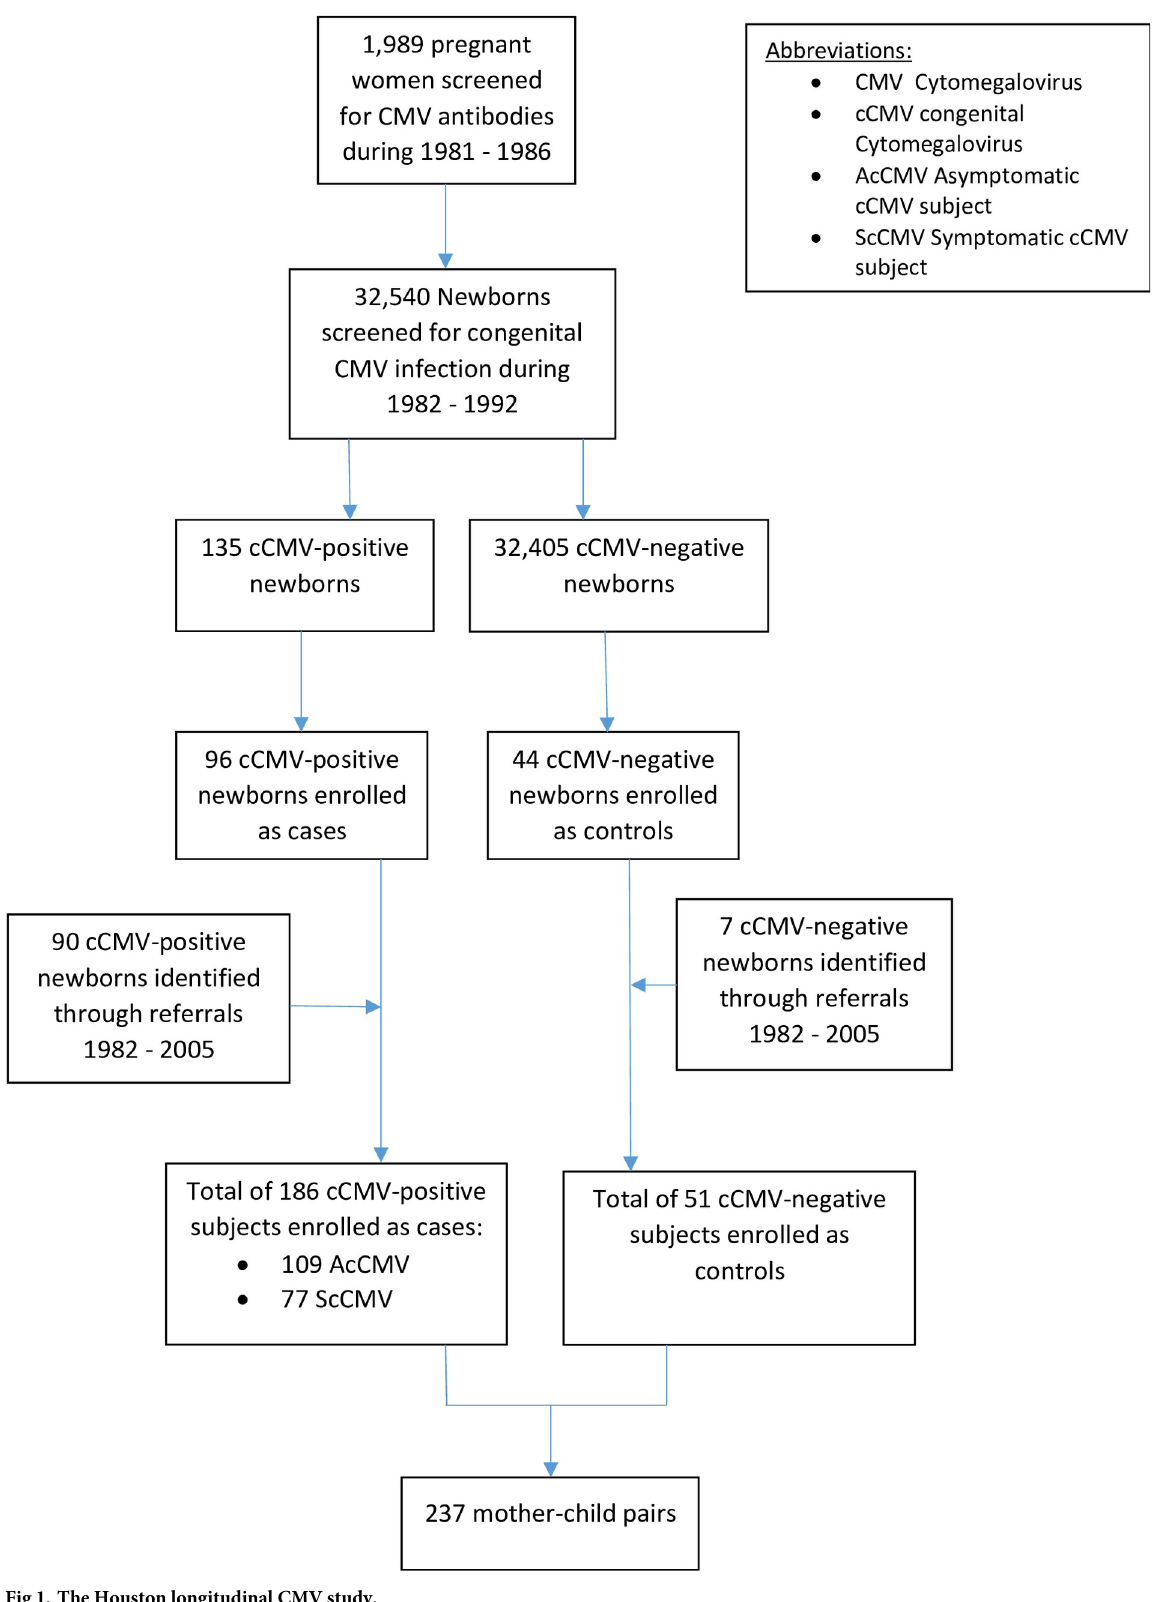
Fig 1. The Houston longitudinal CMV study. https://doi.org/10.1371/journal.pone.0240172.g001 PLOS ONE | https://doi.org/10.1371/journal.pone.0240172 October 9,